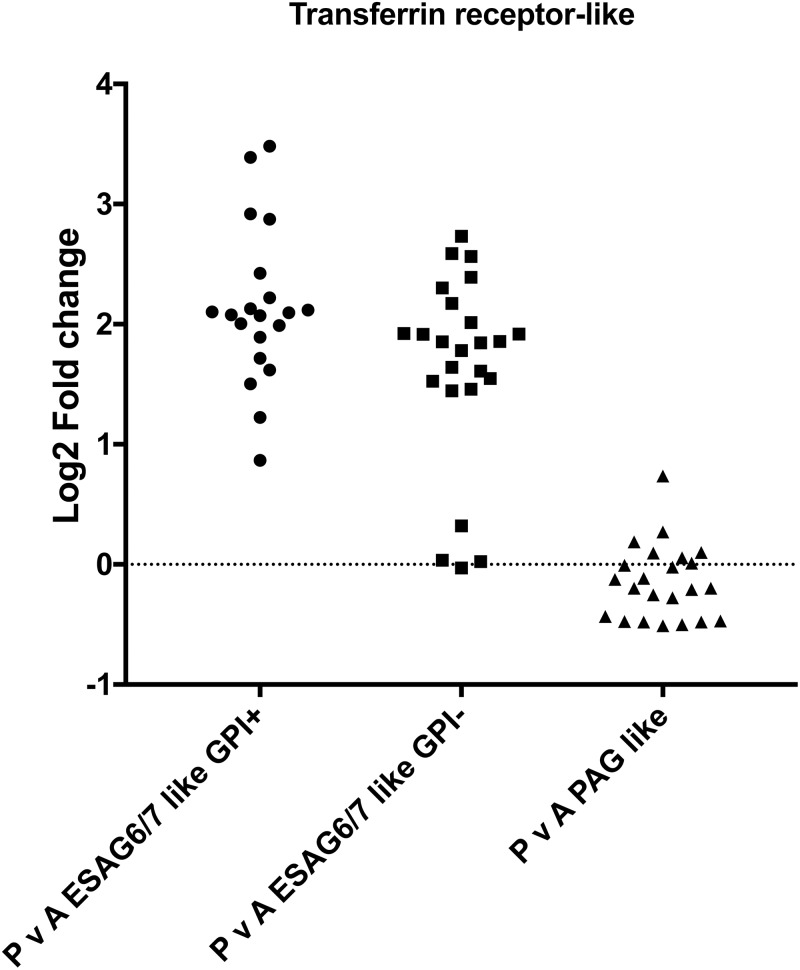
Transferrin family regulation in T. congolense in ascending or peak parasitaemia.Log2 fold change between peak and ascending parasitaemia of T. congolense members of the cell surface phylome family 15 (ESAG6-like transferrin binding, with or without a predicted GPI anchor) and family 14 (PAG-like transferrin binding).